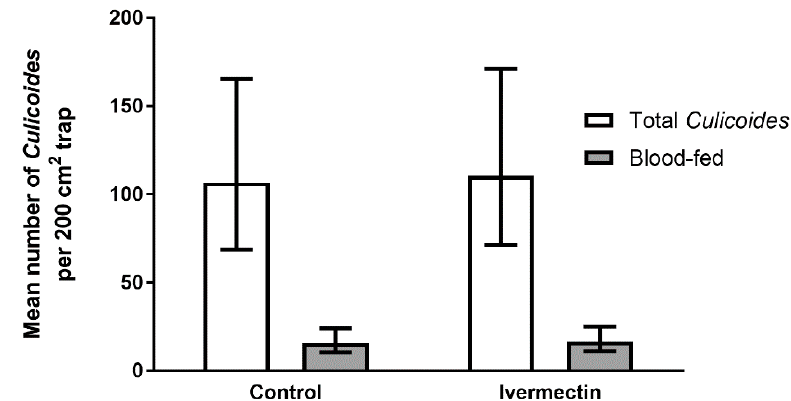
Figure 4. Mean number ( ± 95% confidence intervals) of Culicoides and number blood-fed (grey bars) captured on 200 cm 2 white sticky traps mounted on the backs of Friesian heifers, treated with ivermectin and fenbendazole (control) ( n = 10) and released onto open pasture for 24 h. Data are back-transformed from GLMM predictions.